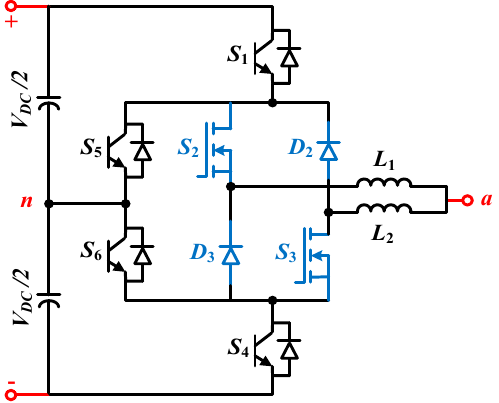
- Figure 3. Schematic diagram of the hybrid ANPC inverter comprising UWBG switches. Figure 3. Schematic diagram of the hybrid ANPC inverter comprising UWBG Table 3. Switching states for the proposed HANPC inverter.